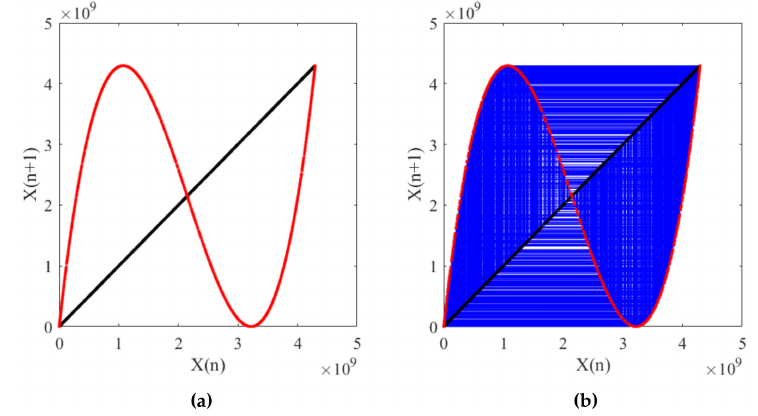
Figure 3. ( a ) Mapping of the 3D Chebyshev map (3D Ch); ( b ) its